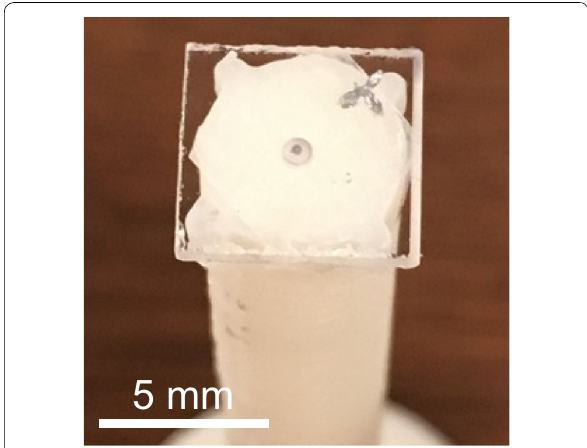
Fig. 2 Image of the glass holder fixed on the ABS holder. 7 mm each side. A plagioclase grain can be seen through the glass in the